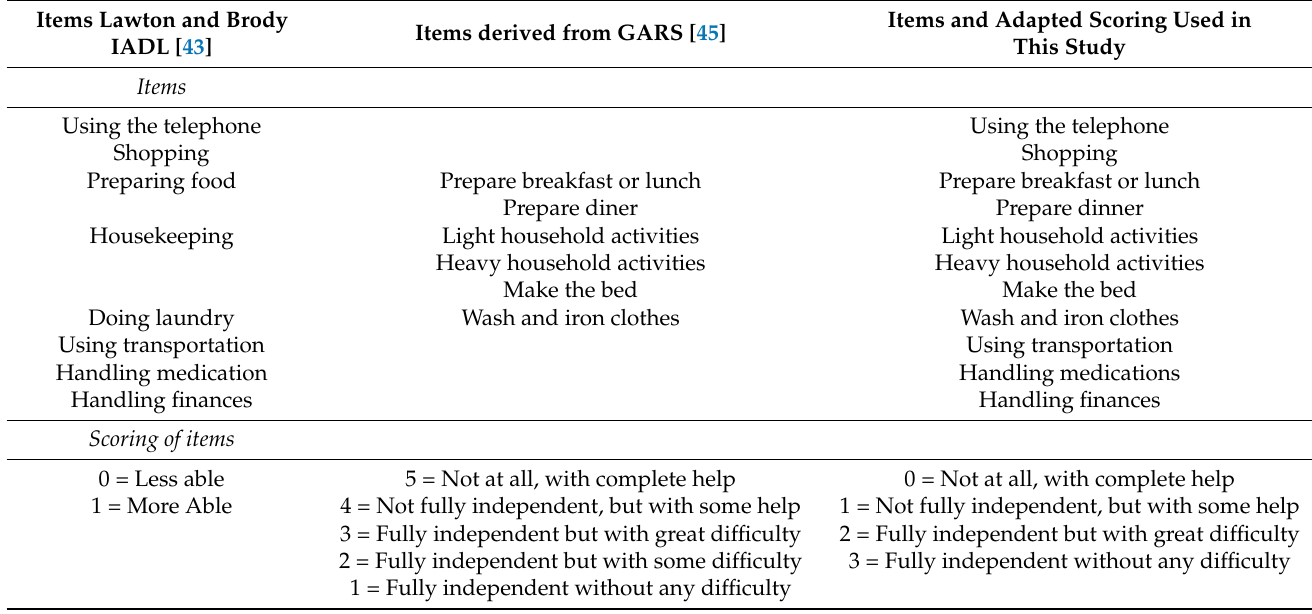
Table 4. Items and adapted scoring based on Lawton and Brody